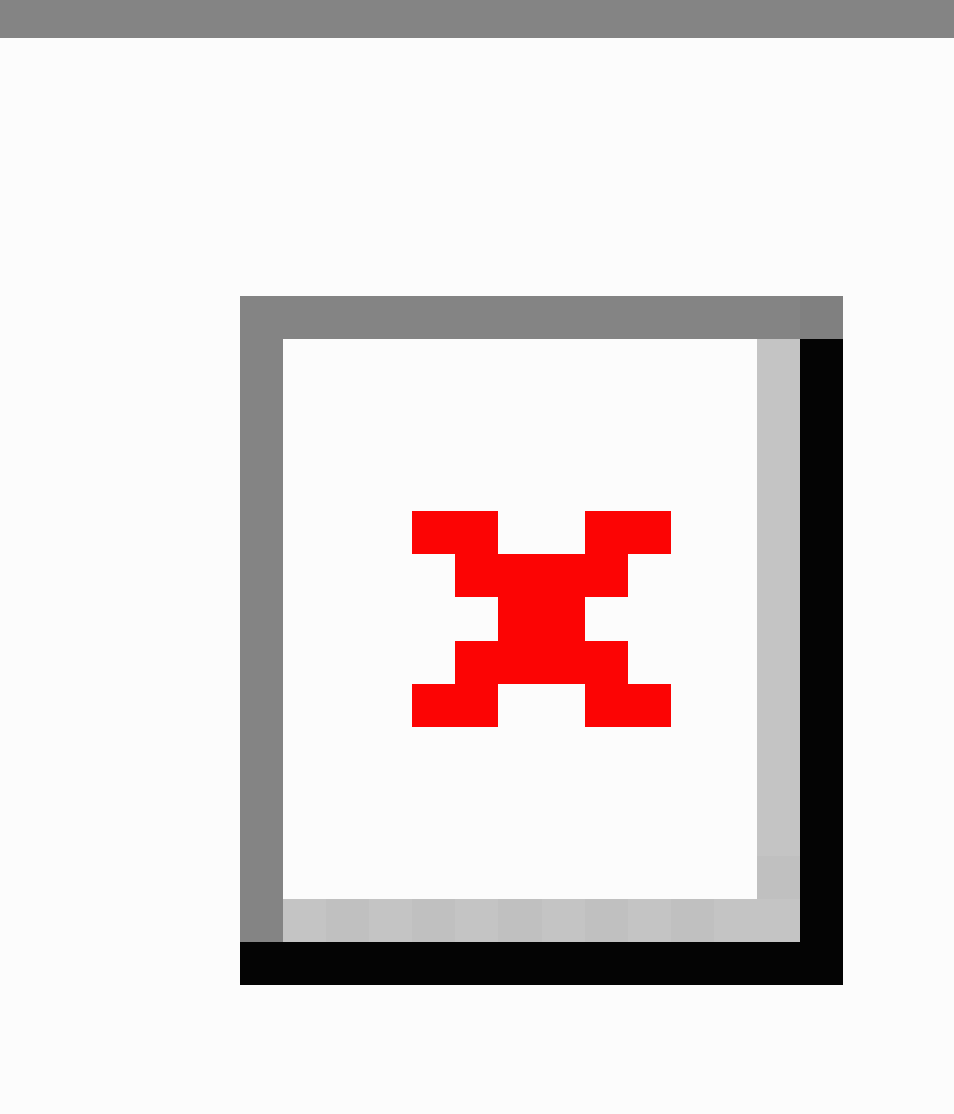
Figure 2. The receiver operating characteristic curves of models established by different algorithms. AUC: area under the